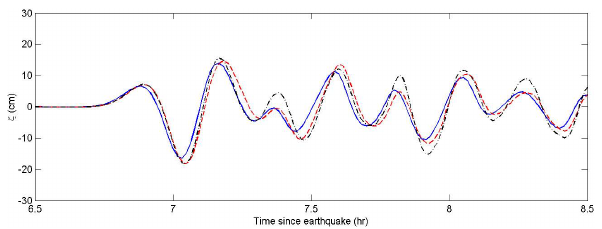
Fig. 16. Time series of water surface elevations output at a numeri- cal wave gage (19.75 ◦ N, 155.07 ◦ W) from Grids A (—), B (- -) and C